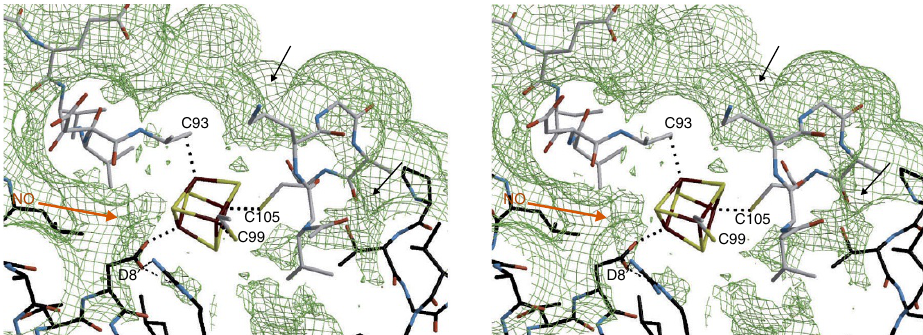
Figure 5 | Stereo view of the FeS cluster environment in ScNsrR. A cavity map calculated with a probe radius of 0.6Å is shown as a green mesh. The orange arrow shows a likely pathway for NO diffusion into the protein. Other plausible access routes are indicated by small black arrows. Atoms are coloured as in Figs 2b and 3. Cluster bonds and H-bonding interactions of Asp8 and Arg12 are shown as dotted and dashed